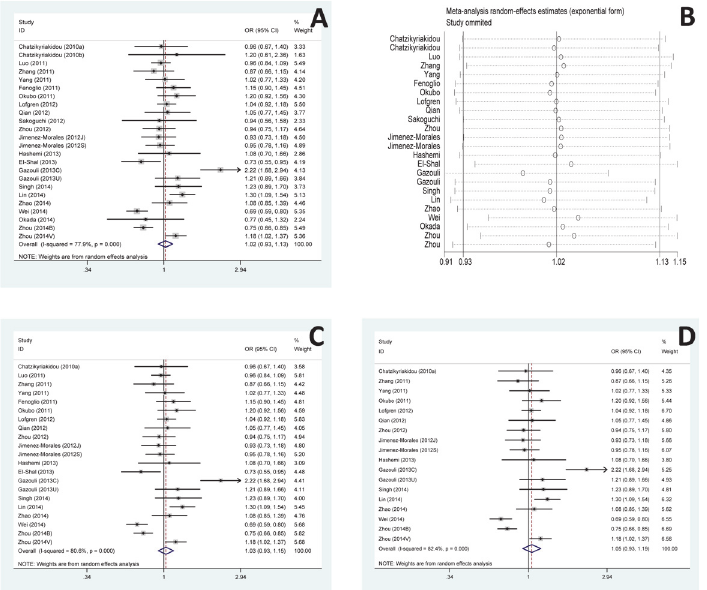
Fig 4. Sensitivity analysis of association of rs2910164 and ADs risk. (A) Pooled analysis of association of rs2910164 and ADs risk. Allele model, C vs G. (B) Sensitivity analysis by iteratively removing one study at a time. (C) Sensitivity analysis by removing three studies with low quality. (D) Sensitivity analysis by removing six studies without